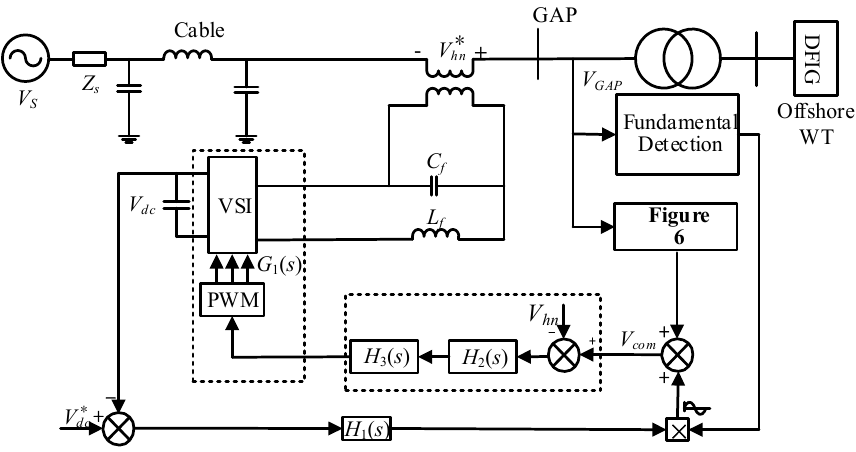
Figure 7. Single phase schematic diagram of series active power filter (APF) compensation.